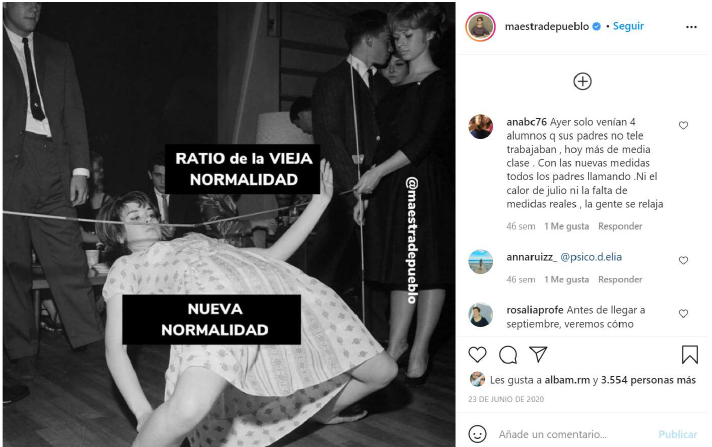
Figure 11. Example of a humorous publication. In this case @maestradepueblo makes a joke about the situation pre-Covid and post-Covid in the educational system. Source: @maestradepueblo.